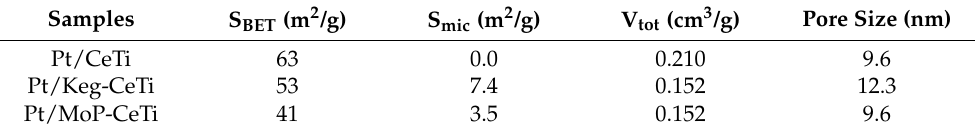
Table 1. Textural and structural properties of the catalyst samples.